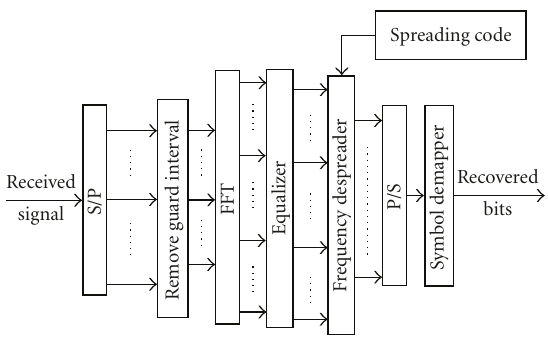
Figure 2: Receiver of an MC-CDMA